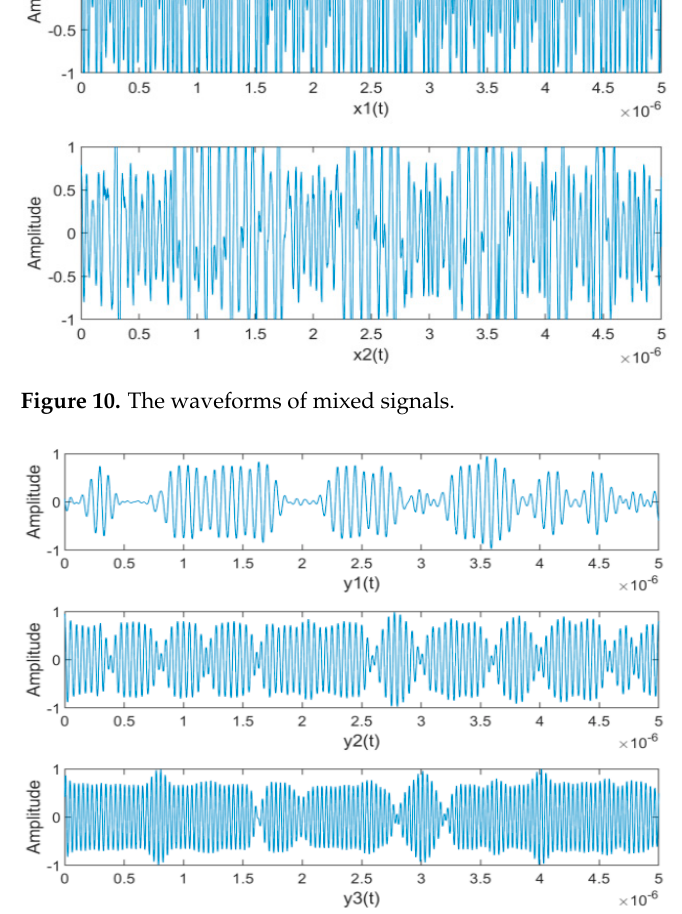
Figure 11. The waveforms of separated signals.